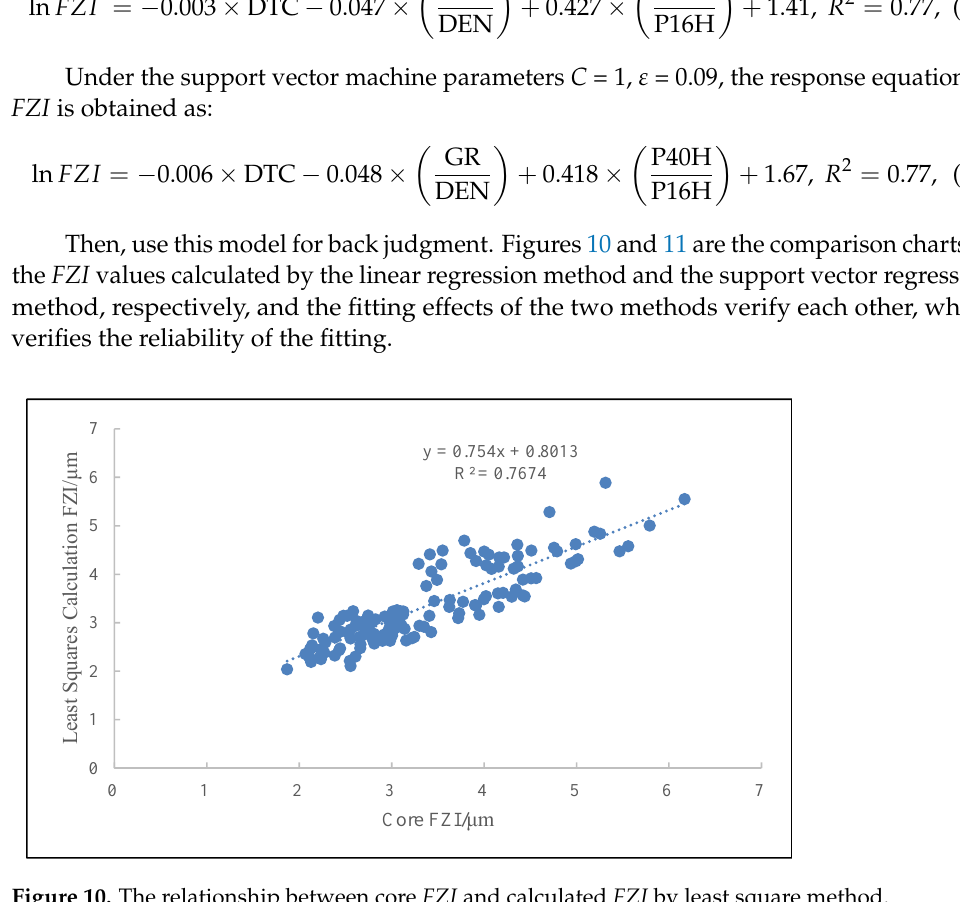
Table 4. Correlation analysis between combination curve and ln (FZI).